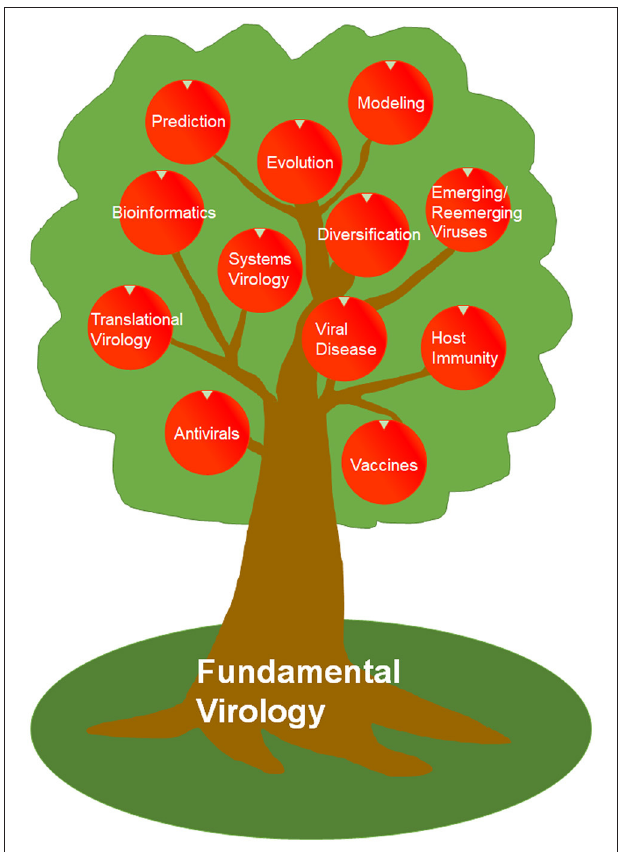
FIGURE 1 | Fruits of the virus research tree. Various research aims/targets for “Frontiers in Virology” ( 3) are symbolically depicted. For detailed descriptions of various specialty sections in “Frontiers in Virology,” see references ( 3,